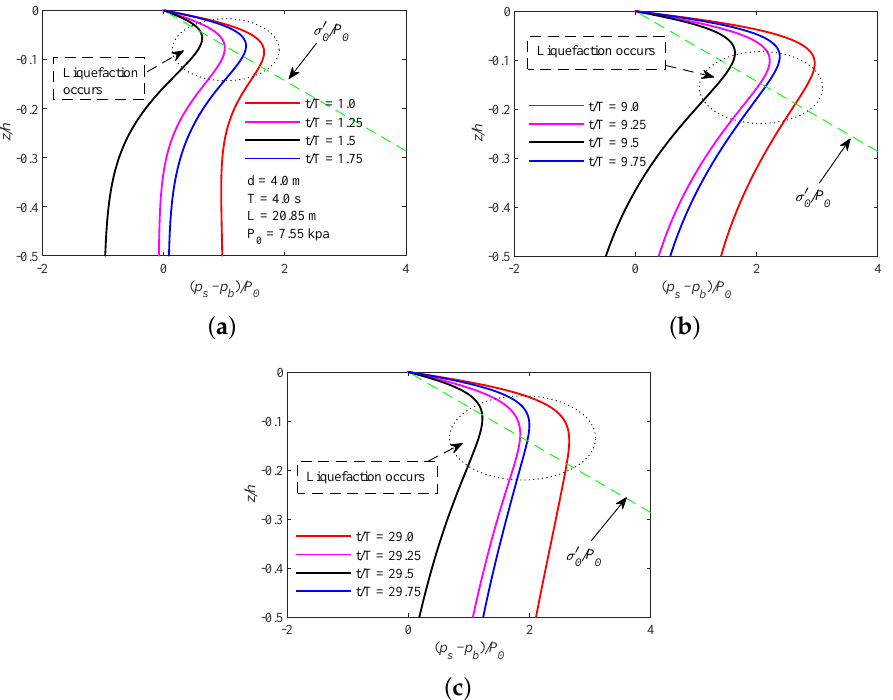
Figure 12. The coupling liquefaction potential (Case 3); ( a ) In the 2nd wave cycle; ( b ) In the 10th wave cycle; ( c ) In the 30th wave